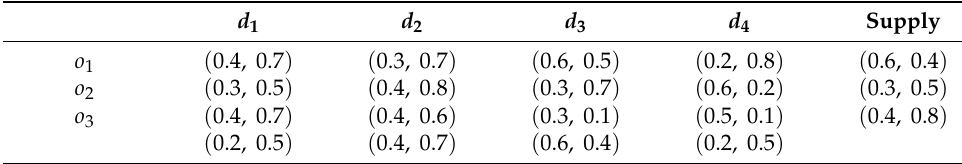
Table 2. Second Objective Cost.